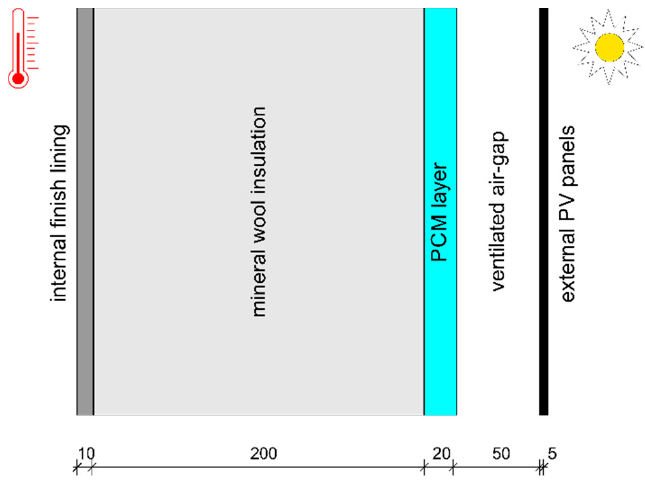
Figure 3. Cross section through the facade equipped with a PCM composite layer, dimensions in millimeters. PV: photovoltaic.